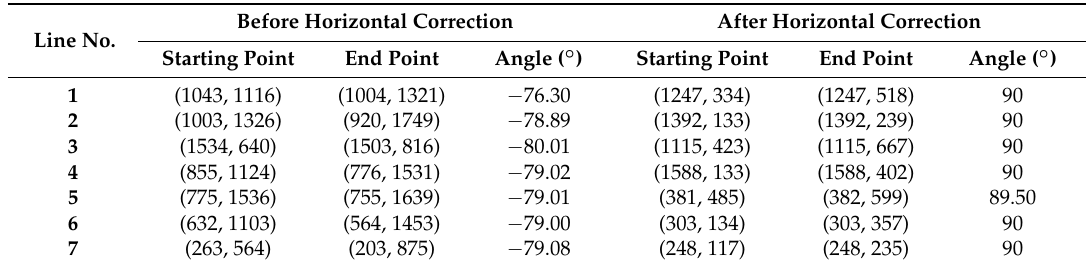
Table 4. Coordinates and angles of each detected plumb line before and after horizontal correction.